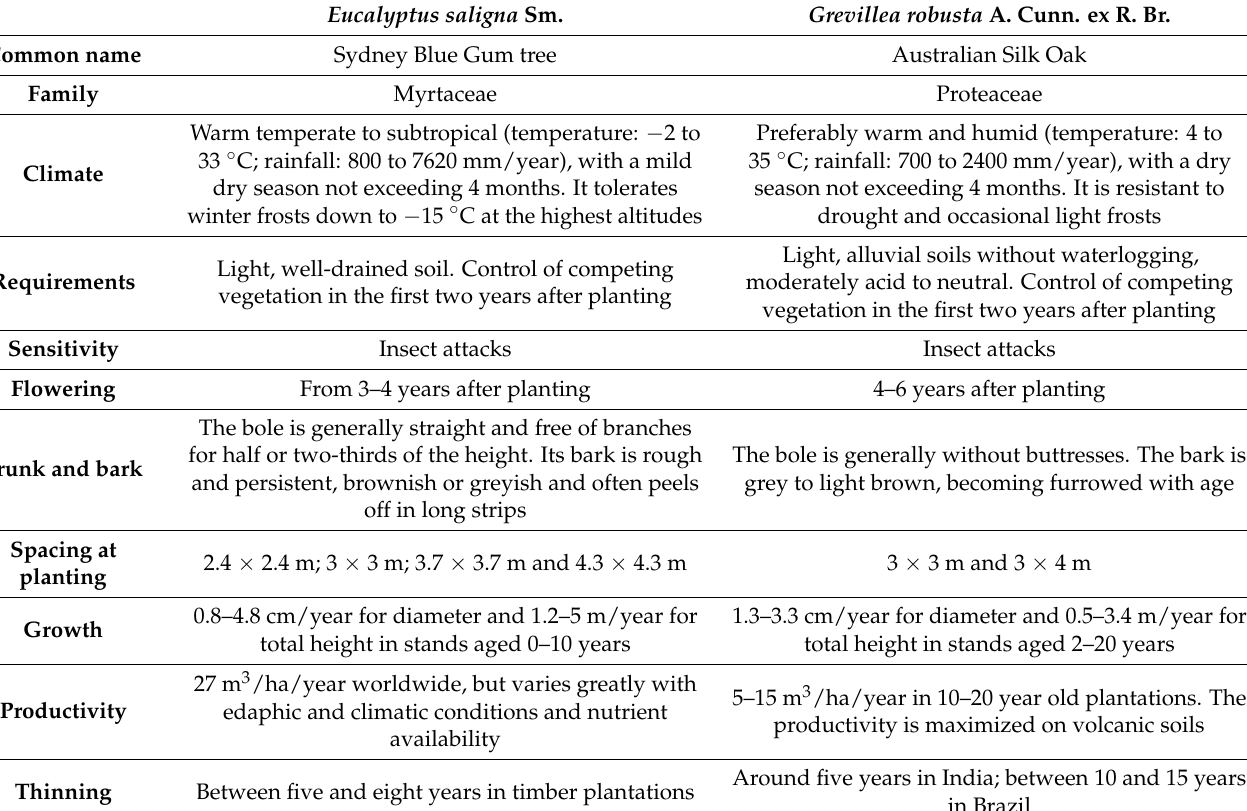
Table 1. Botanical, ecological, silvicultural and cultural characteristics of the tree species used in the studied plantations. Eucalyptus saligna